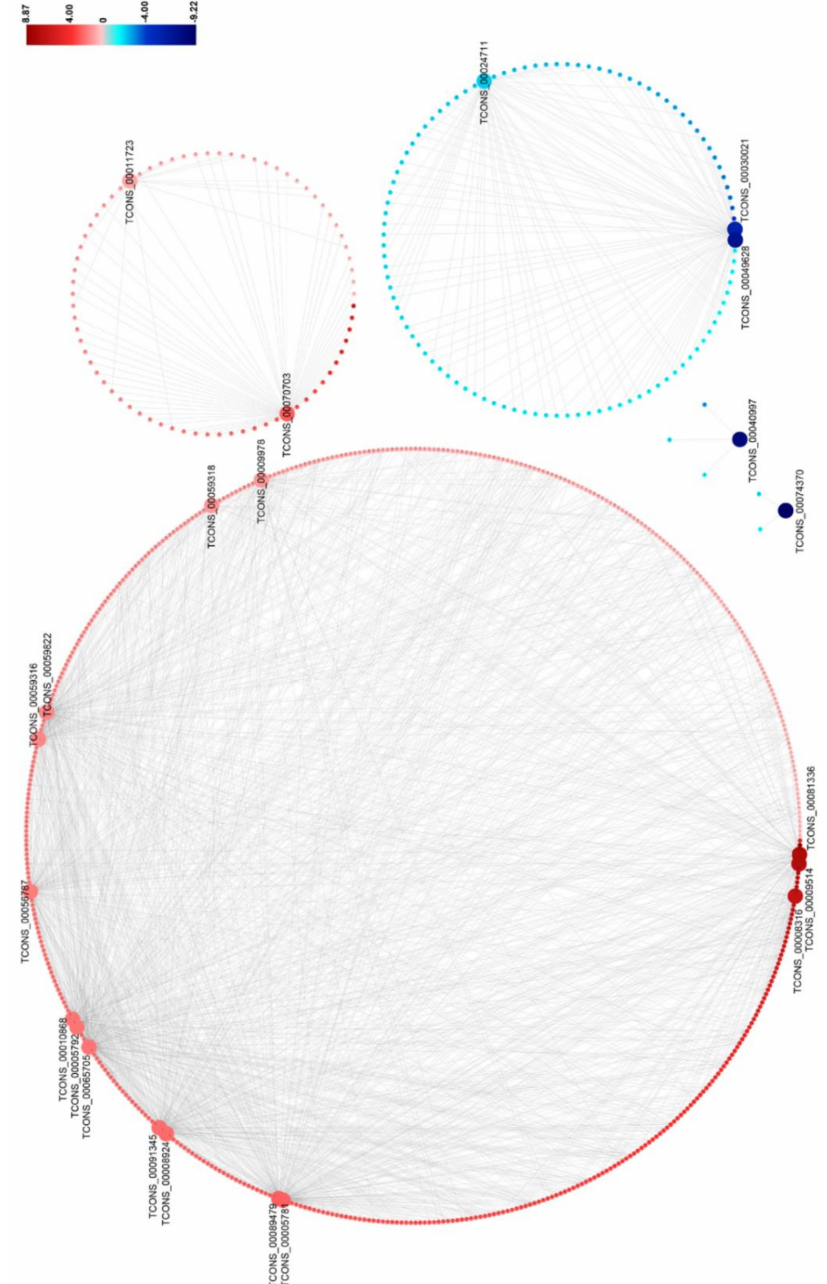
Figure 5. The network for the predicted co-expressed DElncRNA–DEmRNA pairs found in RBSDV-infectedriceplants.Afold-changescaleisshownontherightside.Redindicatesupregulationand blue indicates downregulation. The brighter image is the greater fold change. A DElncRNA–DEmRNA pair with a person’s correlation coefficient > 0.95 or < − 0.95 is considered to be